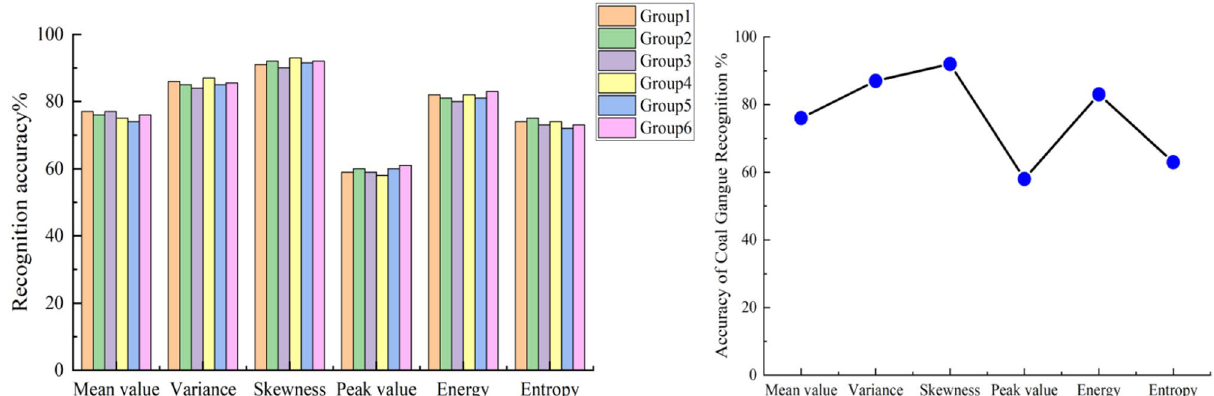
Figure 13. LS-SVM classifier recognition results based on gray